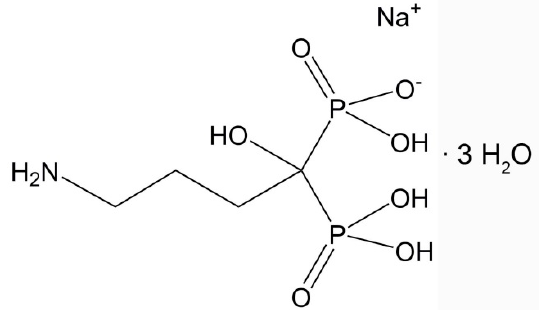
Figure 1. Alendronate sodium.